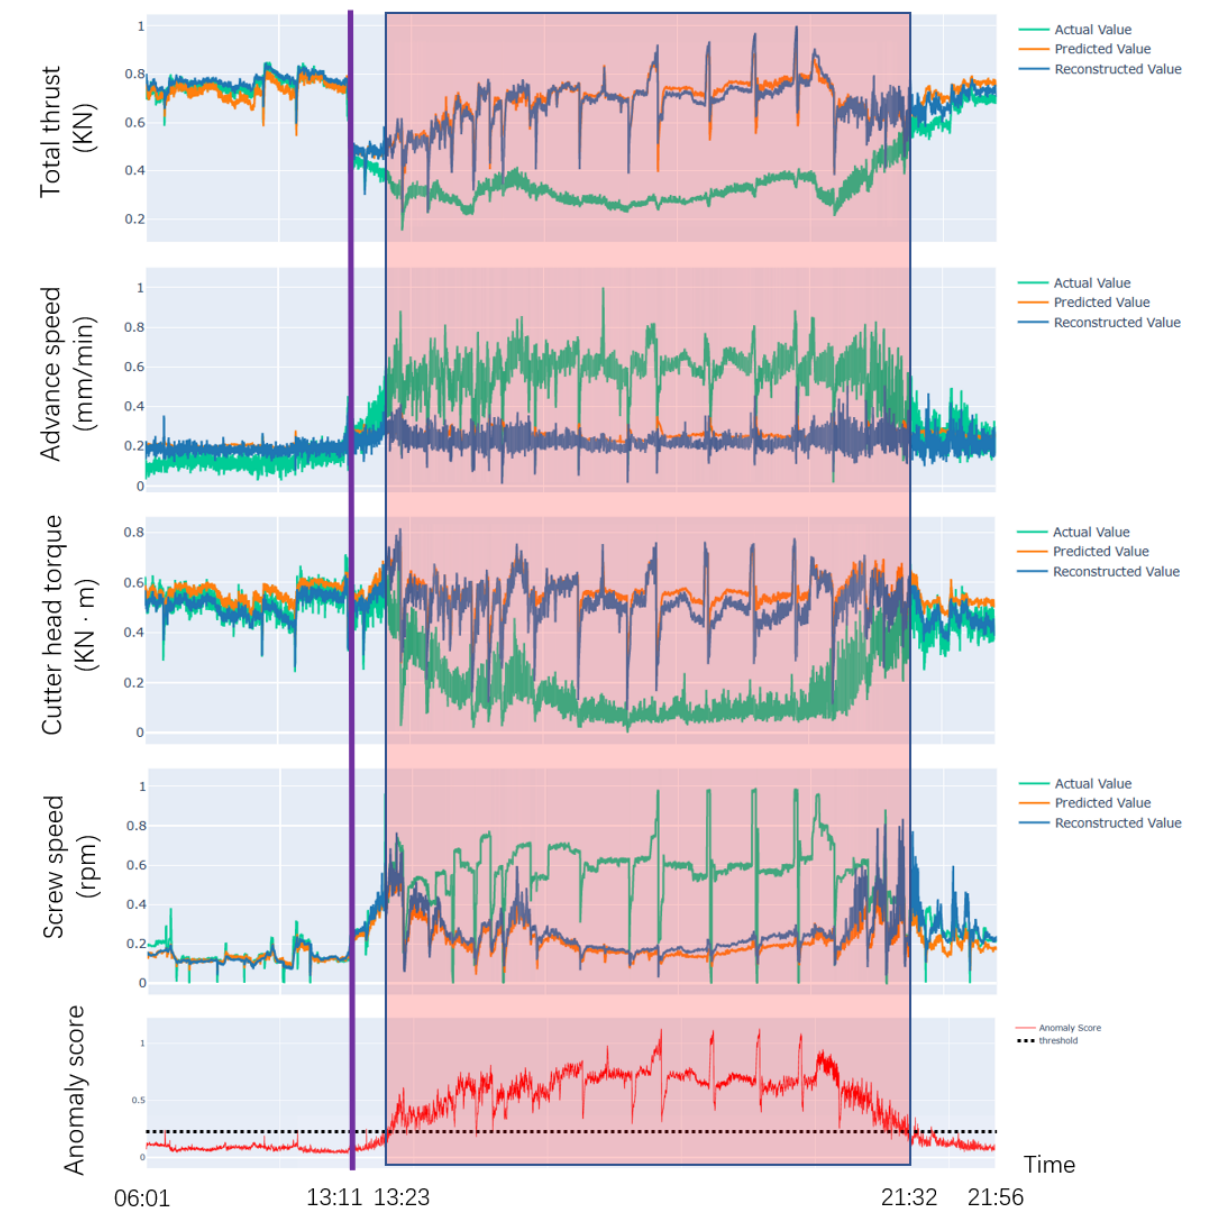
Figure 8. Anomaly detection result